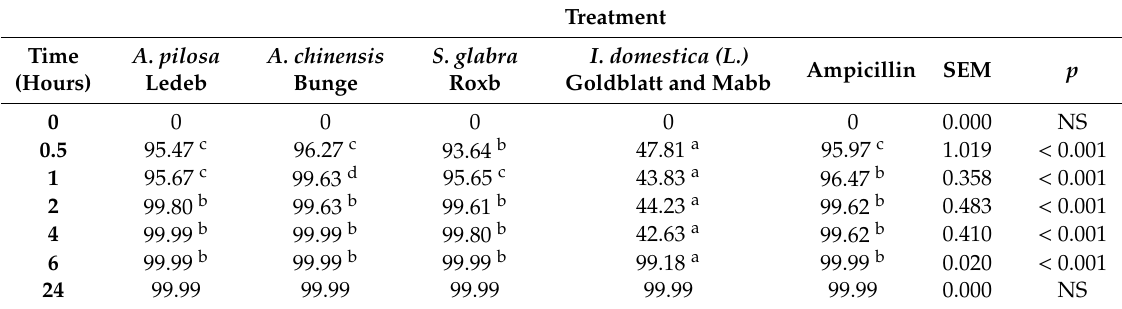
Table 4. Average percentage kill of Listeria monocytogenes NCTC 11994, QA1018, LS12519, and CP102 in the presence of 4 × minimum inhibitory concentration (MIC) of plant extracts and ampicillin over 24 h.